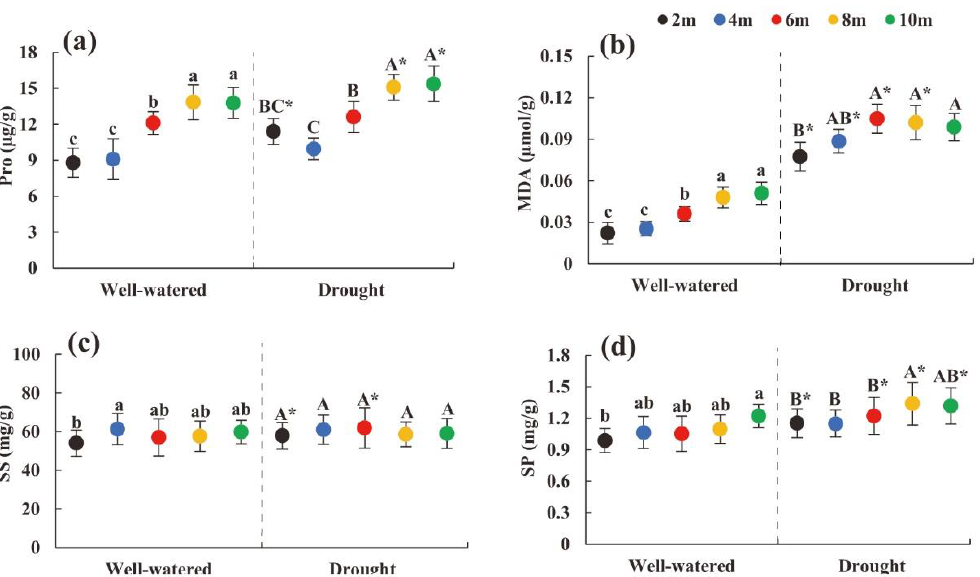
Figure 4. Changes in physiological characteristics of heteromorphic leaves with tree height under different soil moisture conditions. Note: ( a – d ) were changes in proline, malondialdehyde, soluble sugar, soluble protein content with different tree heights under different soil moisture condition. The black dot indicates the height of the 2 m tree, the blue dot indicates the height of the 4 m tree, the red dot indicates the height of the 6 m tree, the yellow dot indicates the height of the tree 8 m, and the green dot indicates the height of the 10 m tree; lowercase and uppercase letters represent the significance of the difference between different sampling heights under suitable soil moisture conditions and soil drought stress conditions, and * represents the comparison of the same height under different habitats ( p < 0.05). Pro: proline; MDA: malondialdehyde; SS: soluble sugar; SP: soluble protein.